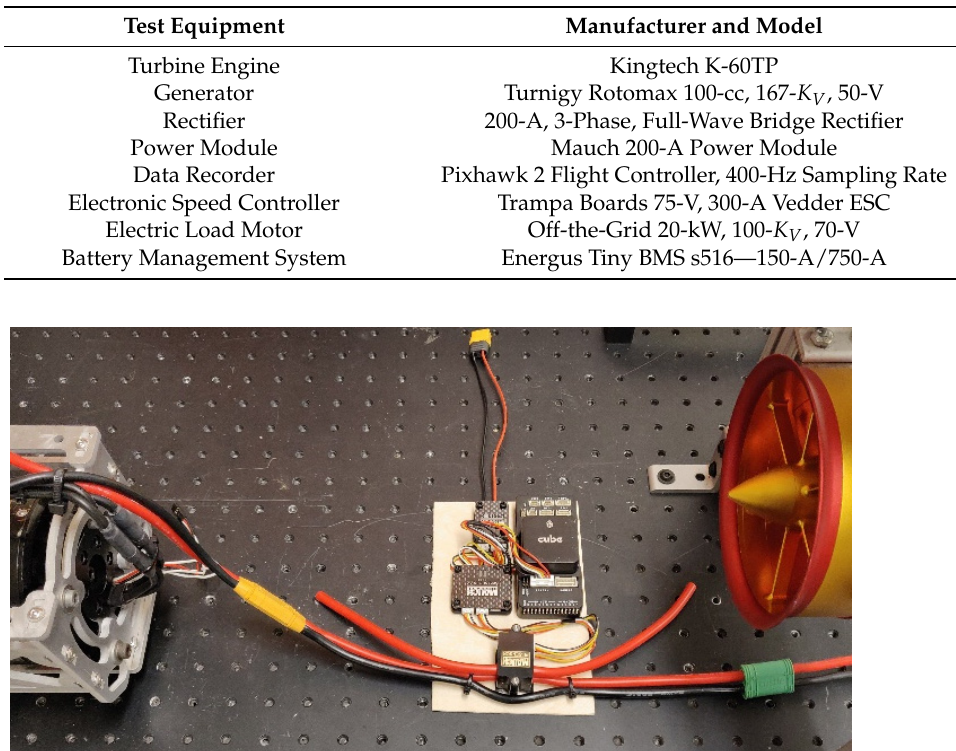
Table 1. Test equipment used during the experimentation.